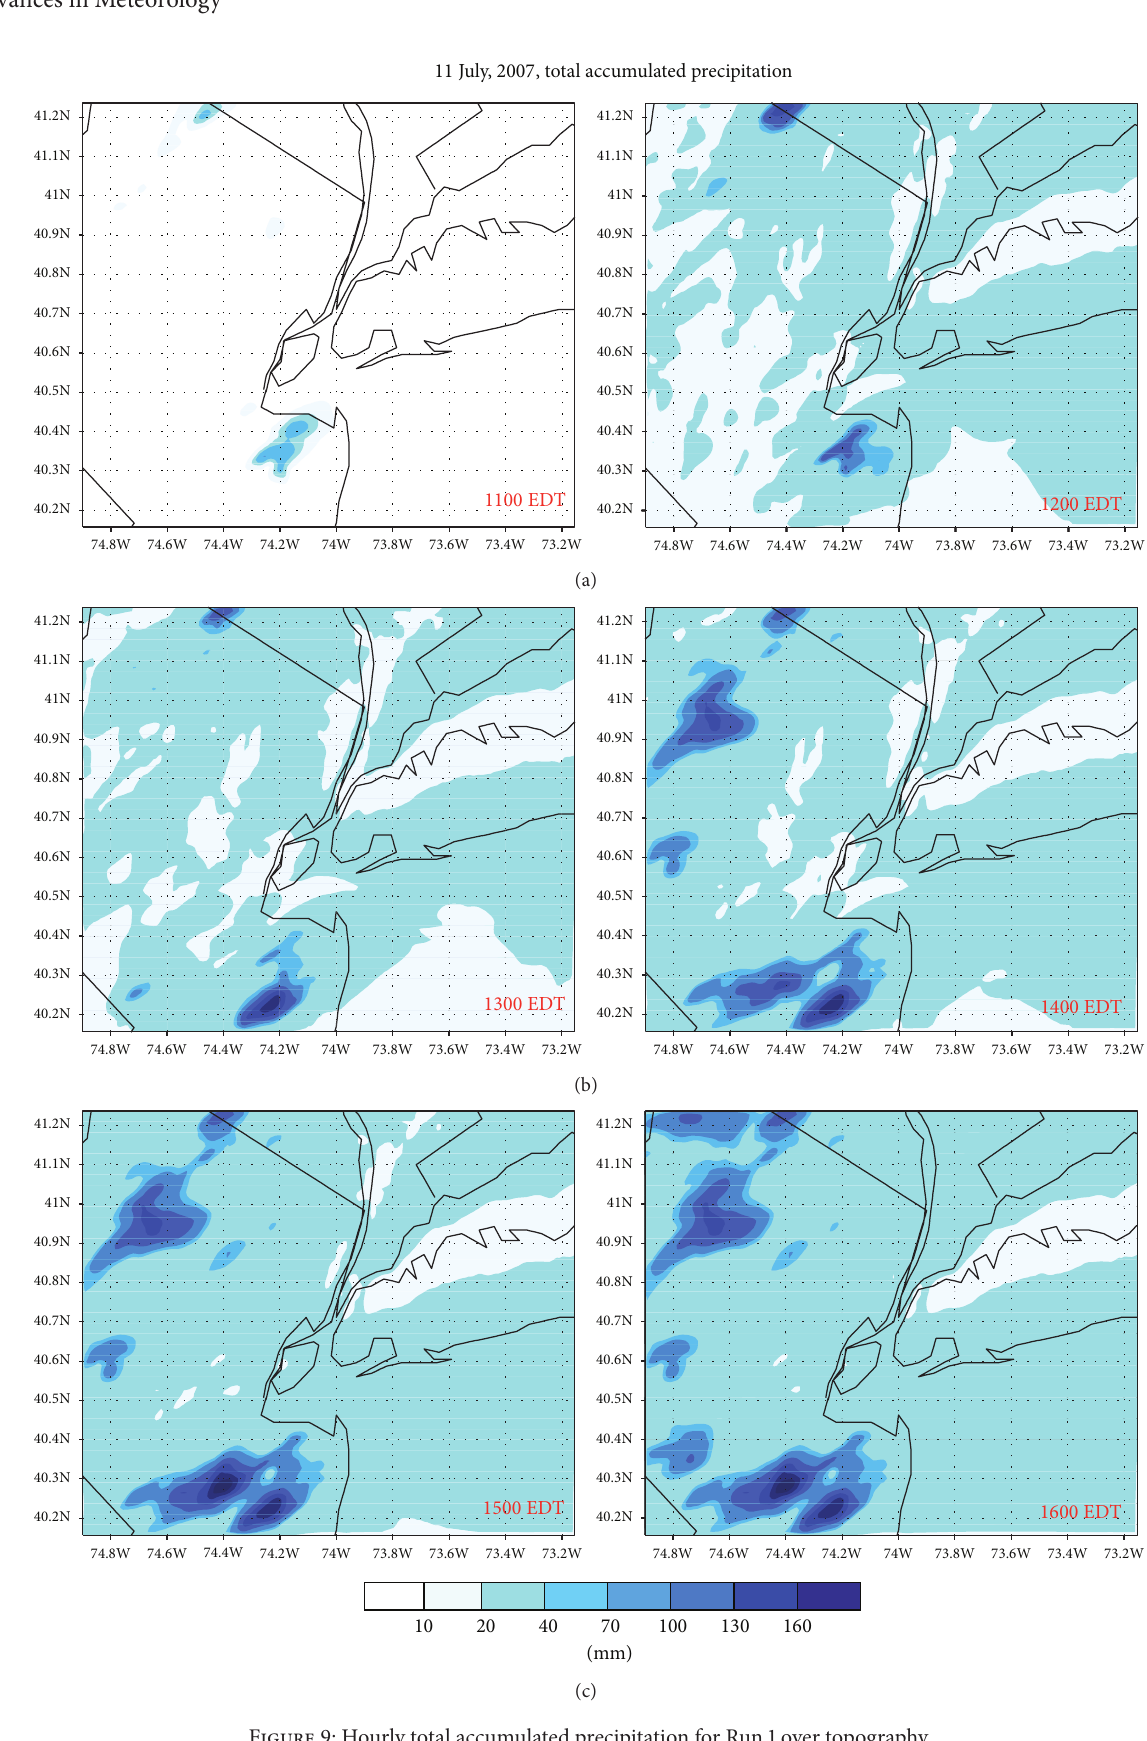
Figure 9: Hourly total accumulated precipitation for Run 1 over